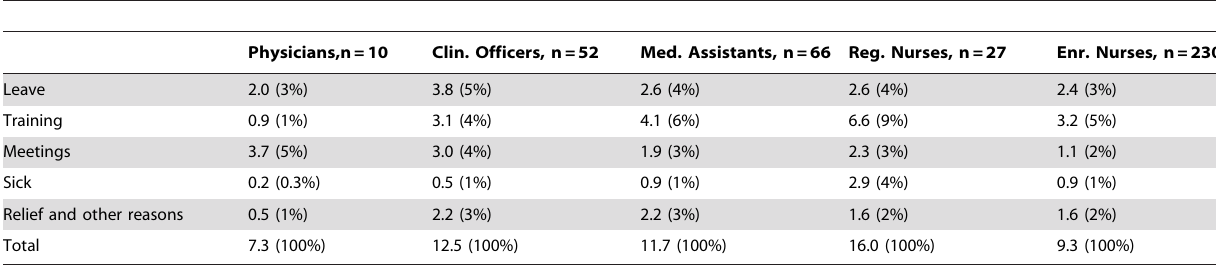
Table 4. Number of days absent per health worker (and percentage of total workdays) during 3 months by reason (n= total numbers of filled positions across all visited